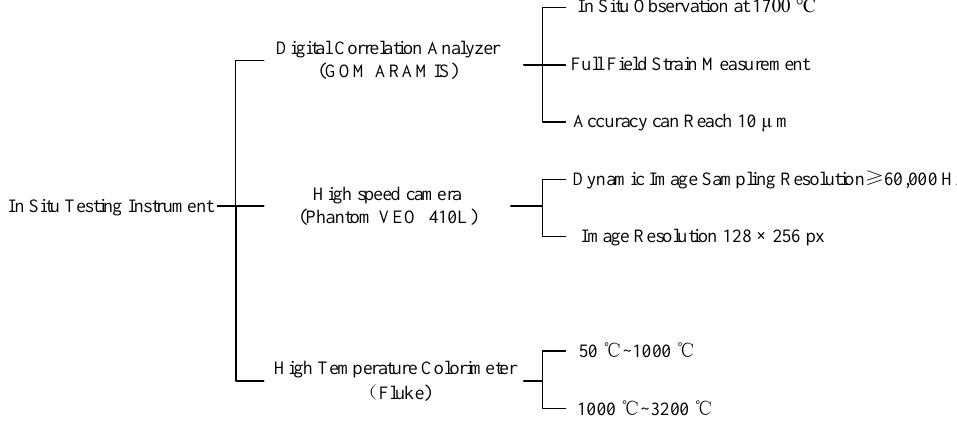
Figure 10. In situ testing device of the high-temperature in-plane biaxial apparatus. The furnace structure incorporates a digital speckle detector, a high-temperature colorimeter, and other in situ testing devices (Figure 11). A medium-frequency induction split heating mode was proposed to achieve maximum temperature uniformity in the observation area. Compared to a one-sided heating mode, split heating provides a more uniform temperature distribution within the specimen gauge area and the convenience of connecting the high-temperature colorimeter with the digital speckle apparatus for in situ testing.